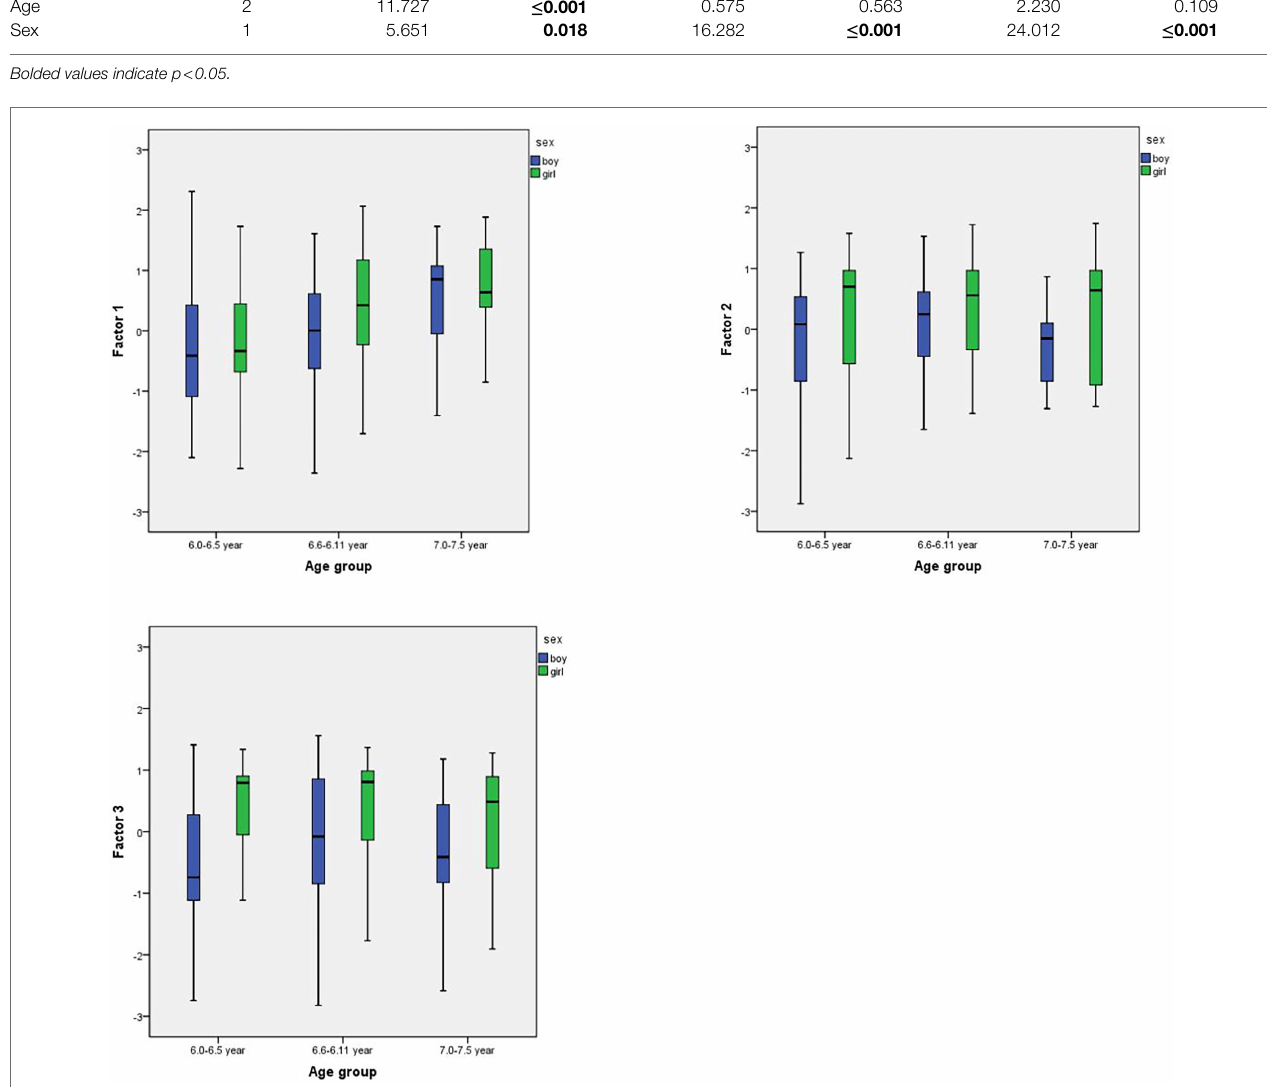
FIGURE 2 | Results of sex and age analysis (Boxploys) on Factor 1 (Leadership), Factor 2 (Preferences), and Factor 3